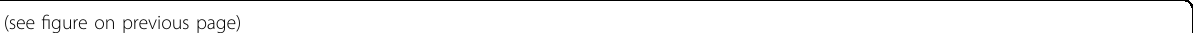
Fig. 6 Inhibition of CER and S1P synthesis alters the M1- and M2-driven effects on post-hepatectomy hepatocytes, respectively. M1 BMDMs and M2 BMDMs were transfected with siRNA-Cers2 (siCers2) and siRNA-Sphk1 (siSphk1), respectively. A scramble siRNA was used as a control siRNA (siCON). Primary hepatocytes were isolated from the remnant liver at POD2 and incubated with CM from the transfected BMDM, then the proliferation and apoptosis of hepatocytes were examined. A , B Transfection was performed at 24 h before induction of polarization. mRNA ( A ) and protein ( B ) levels of Cers2 and Sphk1 were determined at 48 h after polarization. C – F BMDMs with siRNA transfection and their medium were collected to measure the levels of CER metabolites, including d18:1-CER ( C and E ), d18:1-SPH, and d18:1-S1P ( D and F ). G Hepatocytes were fi xed and stained with proliferation marker PCNA and apoptosis maker C-Caspase 3. Top: representative images of immuno fl uorescence staining for PCNA (green). Bottom: representative images of immuno fl uorescence staining for C-Caspase 3 (green). Nuclei were counterstained with DAPI (blue). H , I PCNA-positive hepatocytes and C-Caspase 3-positive hepatocytes were enumerated to evaluate the proliferation ( H ) and apoptosis ( I ) in hepatocytes. J The viability of hepatocytes was measured by MTT assay. Images in B and G represent results from three independent experiments. Data in A , C – F , and H – J were demonstrated as mean ± SD, n = 3; * p < 0.05, ** p < 0.01, *** p <